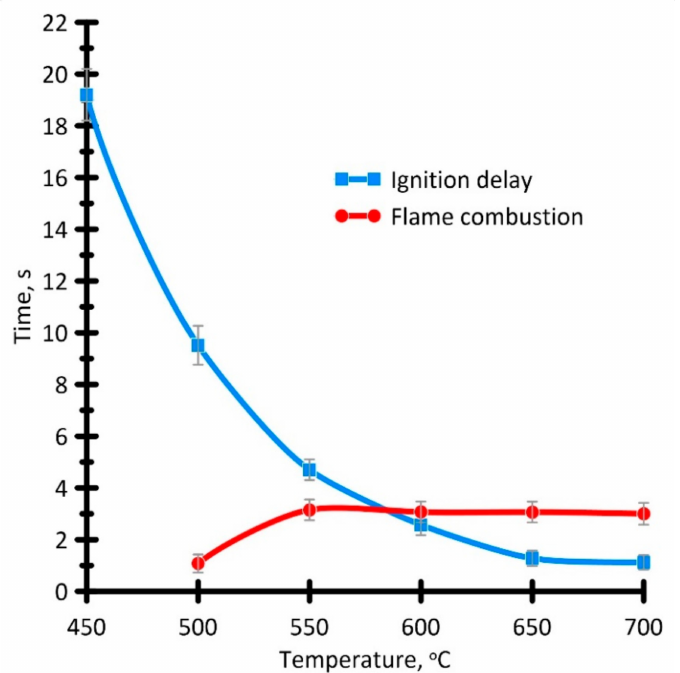
Figure 12. Dependences of the ignition delay and flame combustion time of single droplets of the liquid hydrocarbon sample on the air temperature of 450–700 ◦